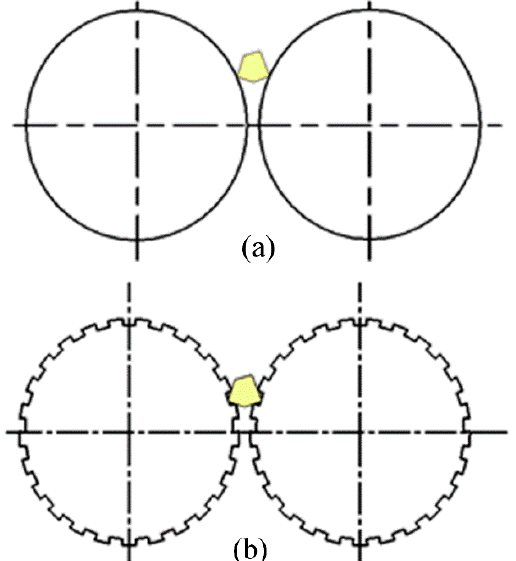
Figure 8. Rolling the quartz sand between different grinding rollers. ( a ) normal grinding roller ( b ) bionic grinding roller.